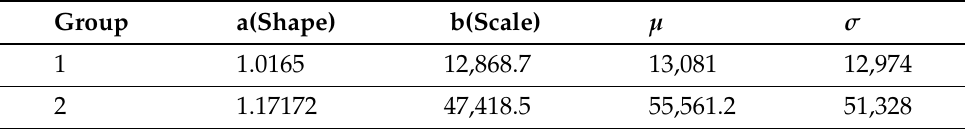
Table 12. Parameter Computation for Category A.